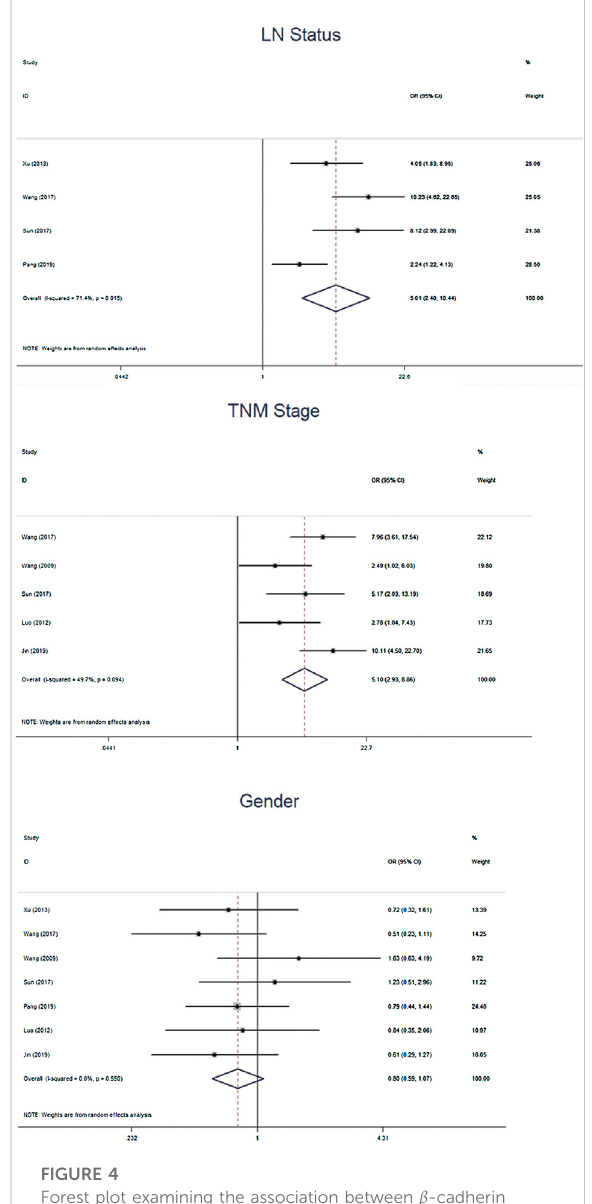
FIGURE 4 Forest plot examining the association between β -cadherin and NPC patients outcomes.